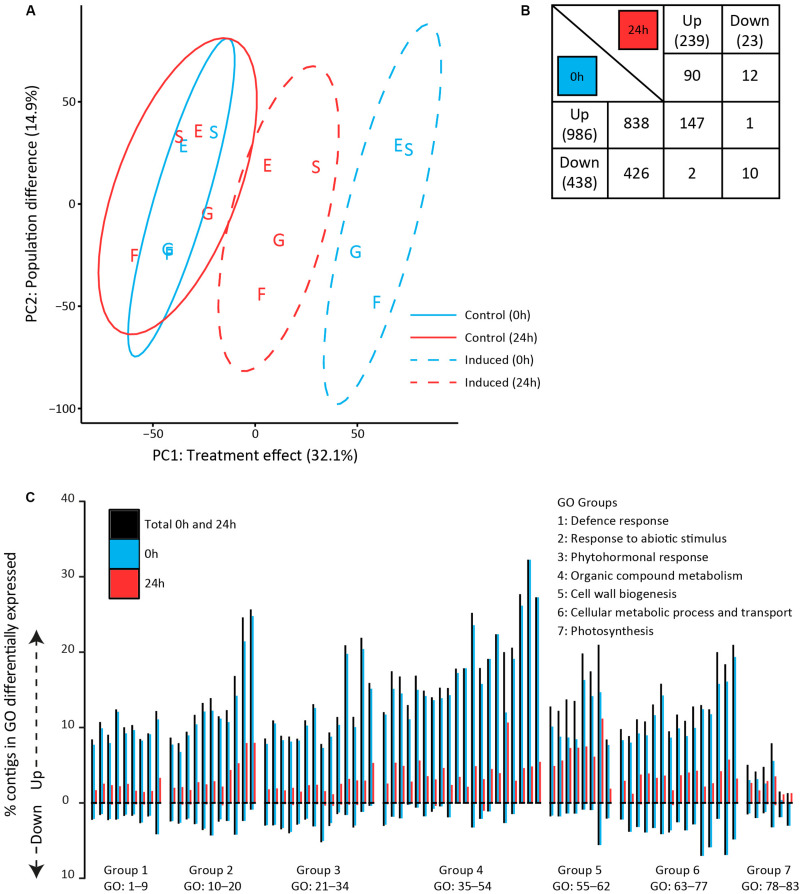
Transcriptomic profiles in Solanum dulcamara leaves upon 24 h of exposure to feeding by the gray field slug (Deroceras reticulatum). Samples were collected directly (0 h; blue) or 24 h (red) after the end of the treatment period (see also Figure 1). (A) Principal component analysis of overall transcriptomic differences among samples (n = 4/treatment/population). Ellipses show 95% confidence intervals. Letters indicate the plant population of origin; E, Erkner; S, Siethen; G, Goeree; F, Friesland. (B) Numbers of significantly up- and downregulated contigs that are unique for, or shared among harvest time points (fold change >2, Padj < 0.05, n = 4). The total number of regulated contigs at each time point is given in brackets. (C) Percentage of contigs that was significantly up- or downregulated in 83 gene ontology (GO) terms. GO terms were grouped according to overall involvement in biological processes and sorted based on the number of contigs in each term (group numbers correspond to the numbers in Table 3).